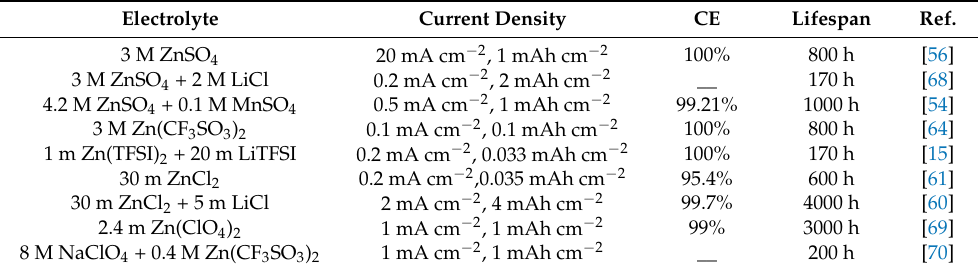
Table 1. Recent publications focused on high − concentration electrolytes in ZIBs. Electrolyte Current